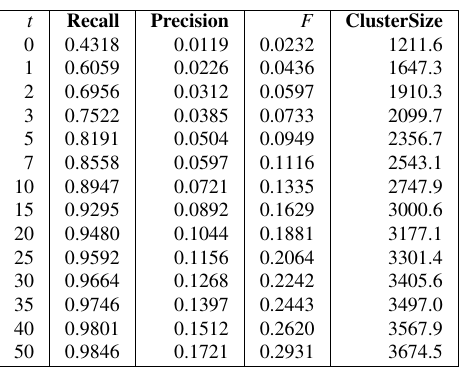
Table 3. f simple ⊆ classifier